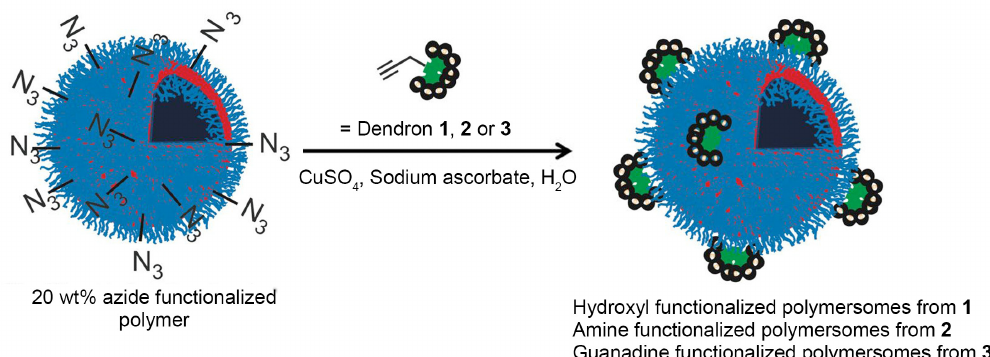
FIGURE 8 - “Click” conjugation of dendrons 1 , 2 , and 3 to azide functionalized PBD-PEO polymersomes to provide dendritic hydroxyl, amine, and guanidine functionalized polymersomes respectively (Amos et al. , 2012).